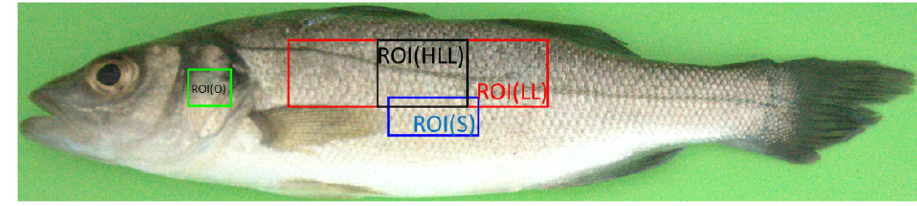
Figure 5. Different seabass ROIs that were used for